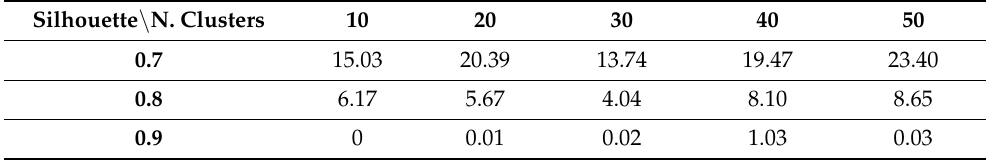
Table 10. Clustering performance in terms of silhouettes using normalized data. Silhouette \ N.